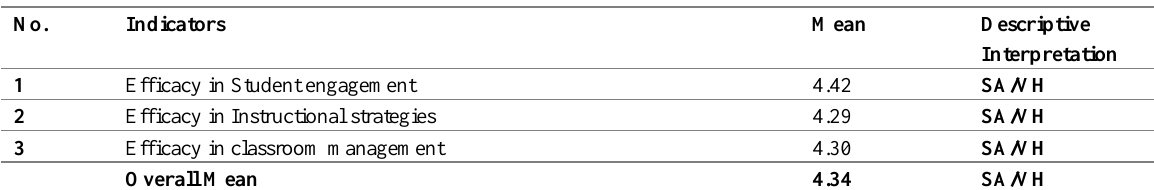
Table 4: Summary